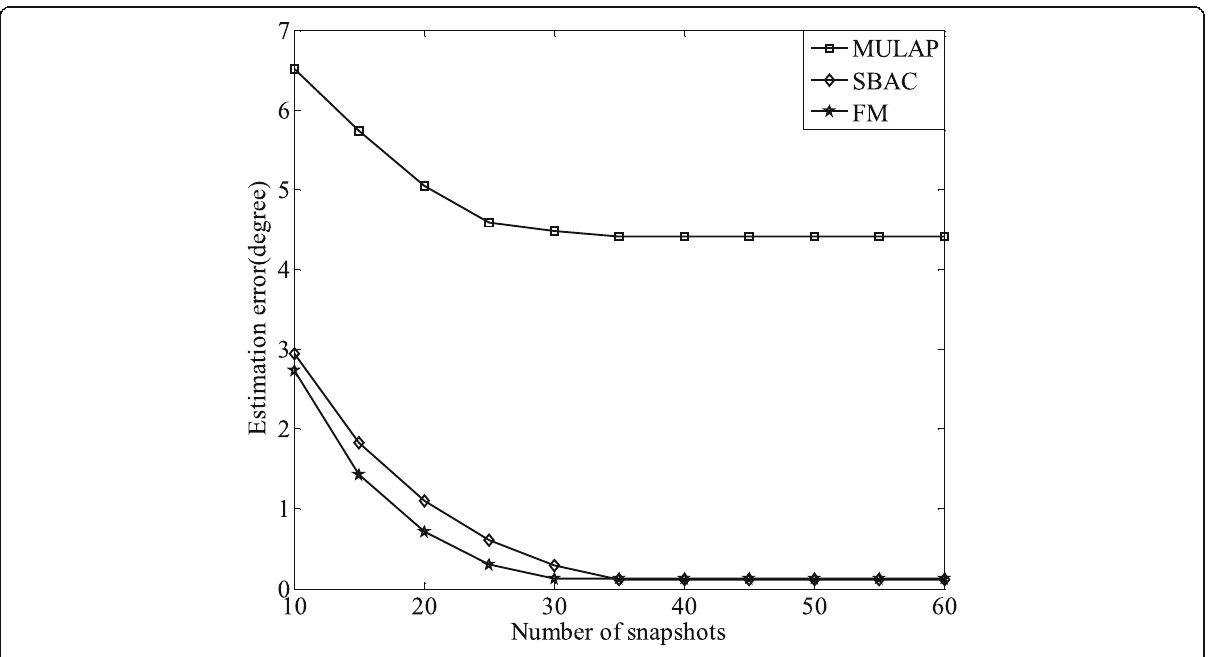
Fig. 5 Estimation errors versus number of snapshots